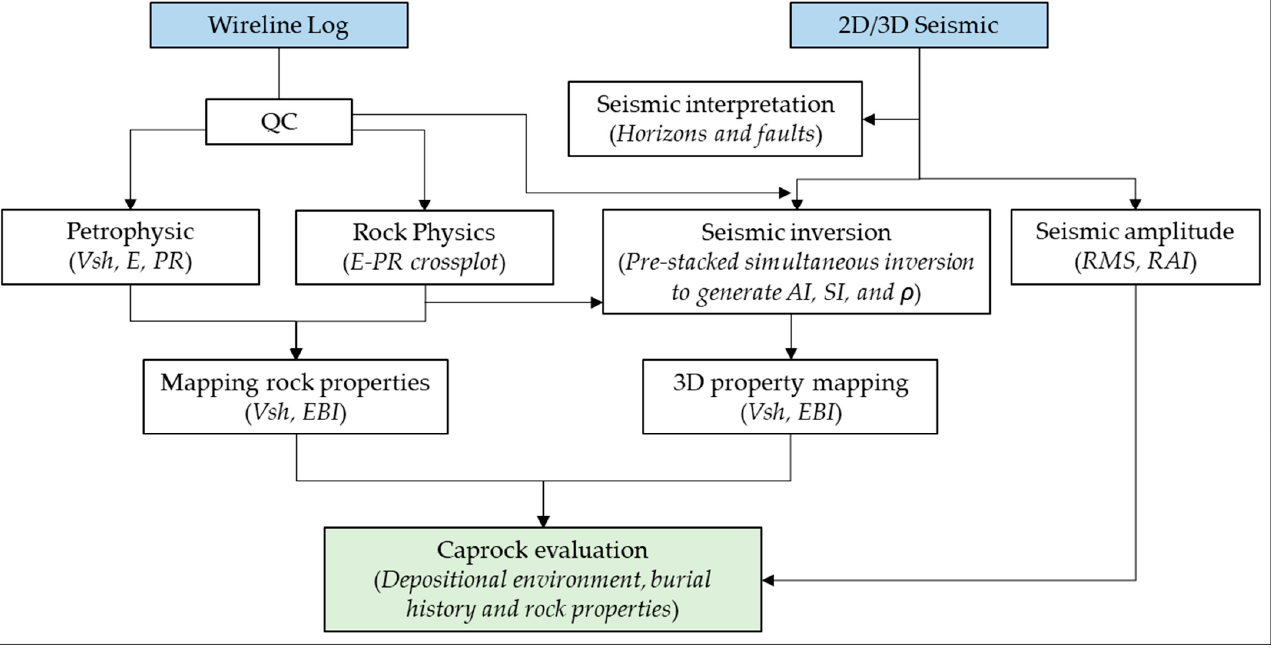
Figure 5. An integrated workflow to illustrate the caprock evaluation processes.